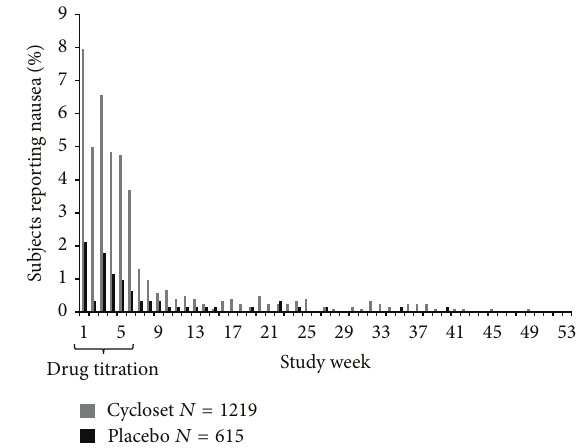
Figure 3: Occurrence of nausea (most commonly reported adverse event) by study